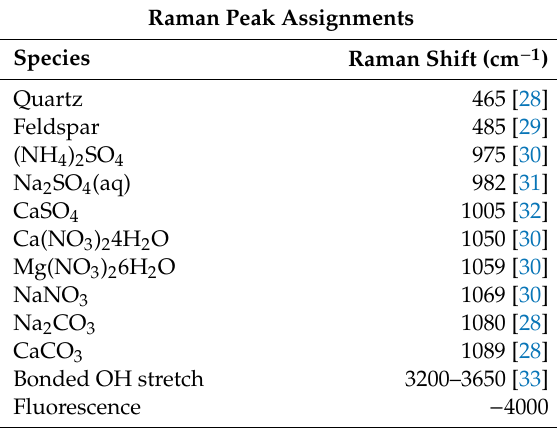
Table 1. Peak assignments for Raman shift obtained in this study.